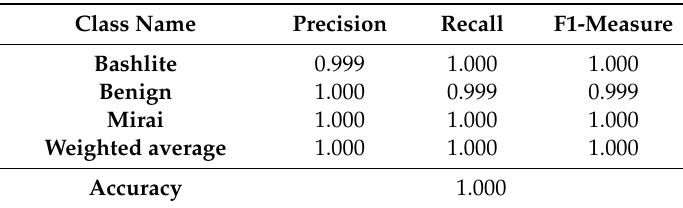
Table 3. Results for performance evaluation measures when detecting attack and benign classes using